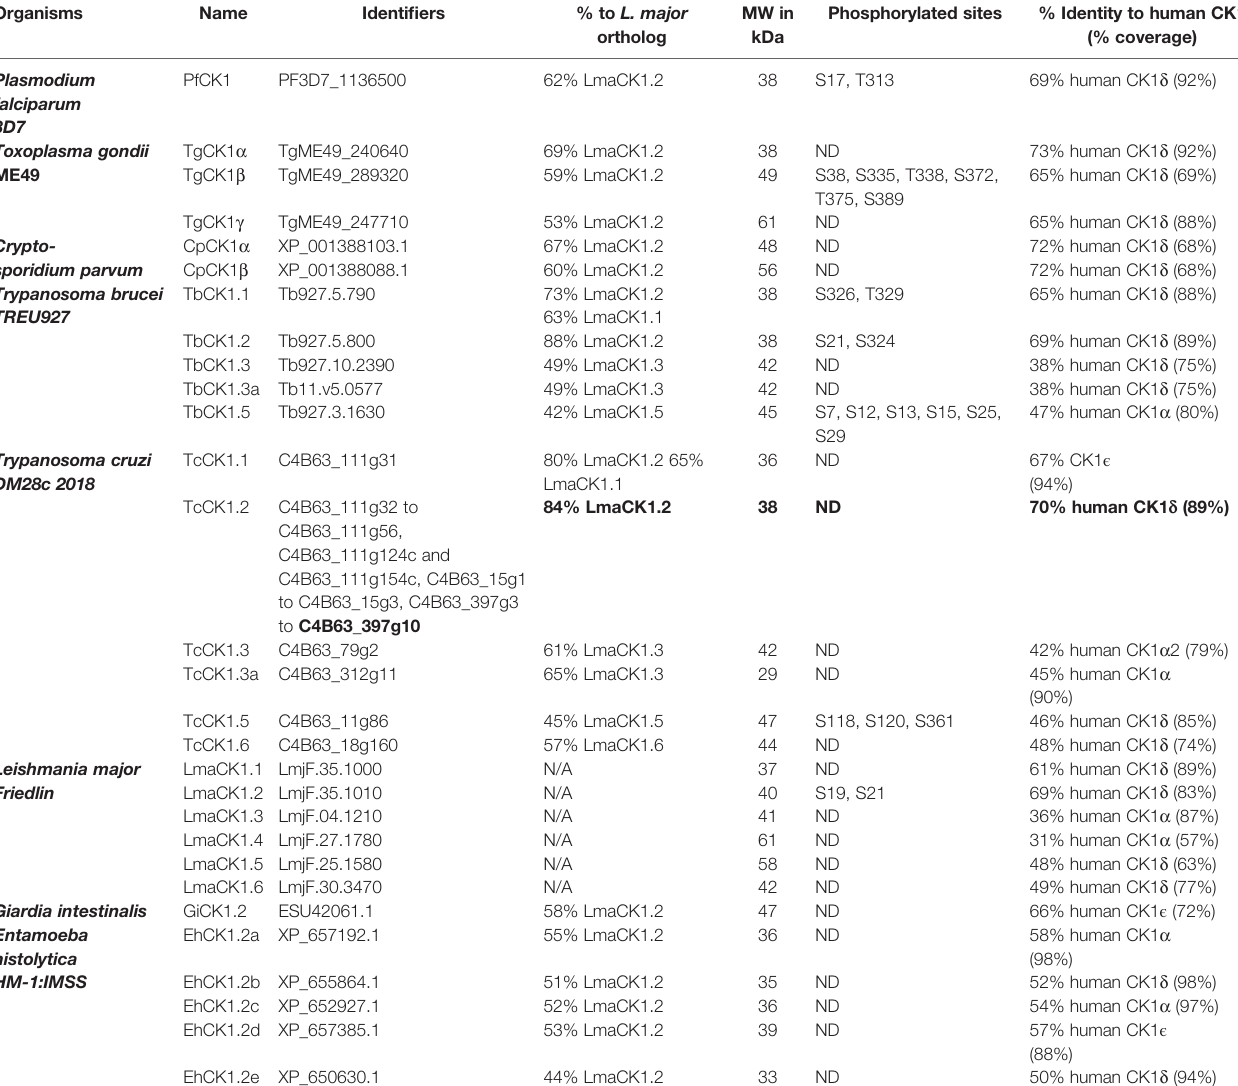
TABLE 1 | CK1 in parasites.